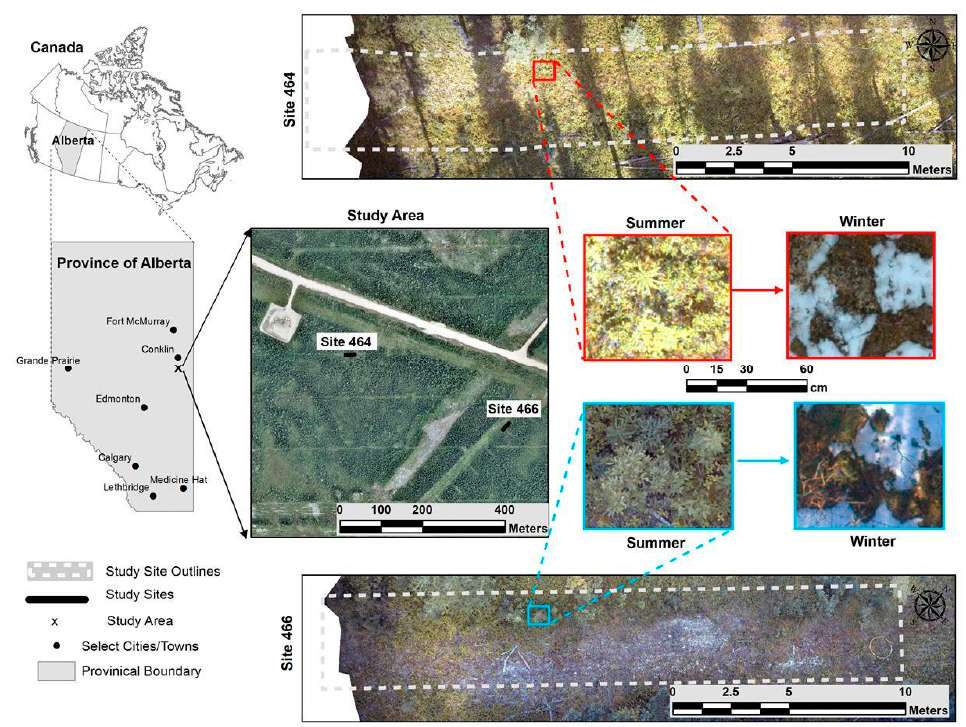
Figure 1. Experiments took place at two sites in the boreal forest south of Conklin Alberta, which we refer to as site 464 and site 466. Both are short (~25 m) segments of seismic lines (petroleum-exploration corridors) containing regenerating seedlings. Imagery over the sites was obtained in both leaf-on (‘summer’) and leaf-o ff (‘winter’)